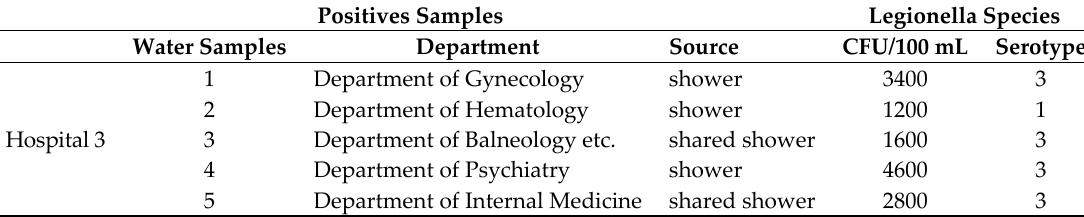
Table 2. Positive